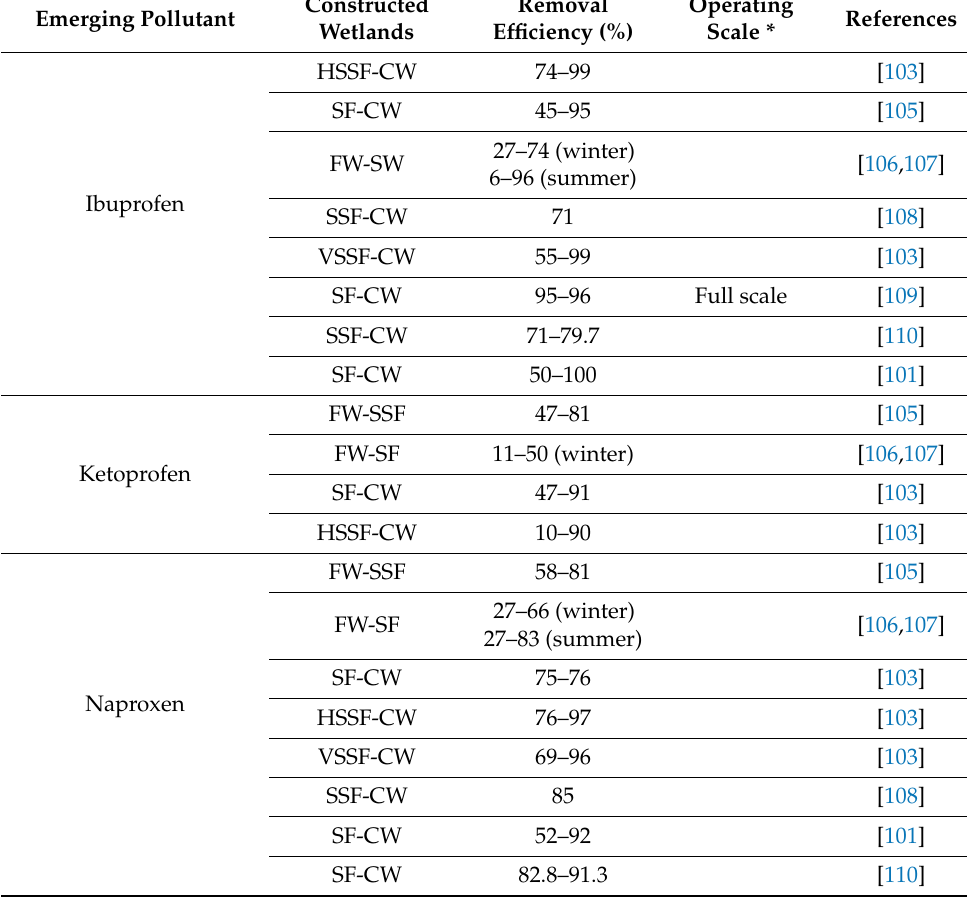
Table 6. Efficiency of EPs removal in constructed wetlands (CWs). Emerging